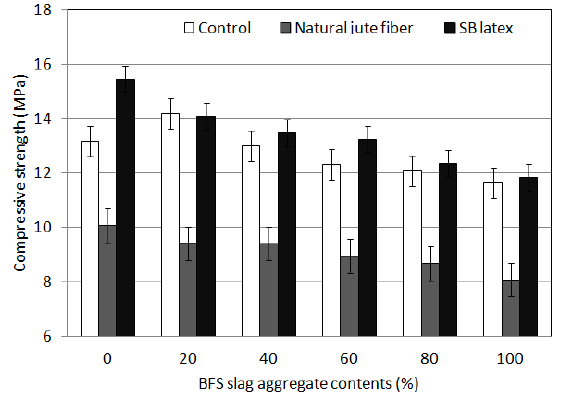
Figure 4. Compressive strength results of porous concrete for plant growth.